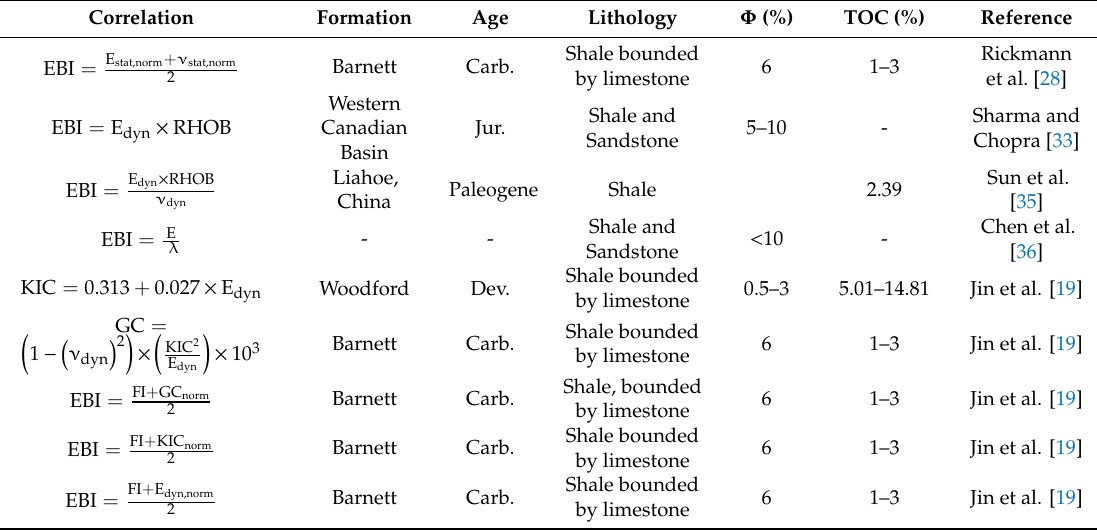
Table 3. Summary of EBI correlations based on elastic